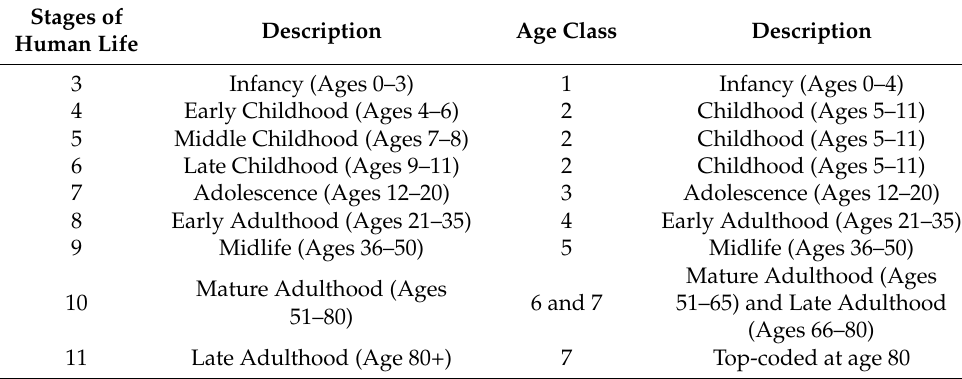
Table 1. Stages of human life and corresponding age